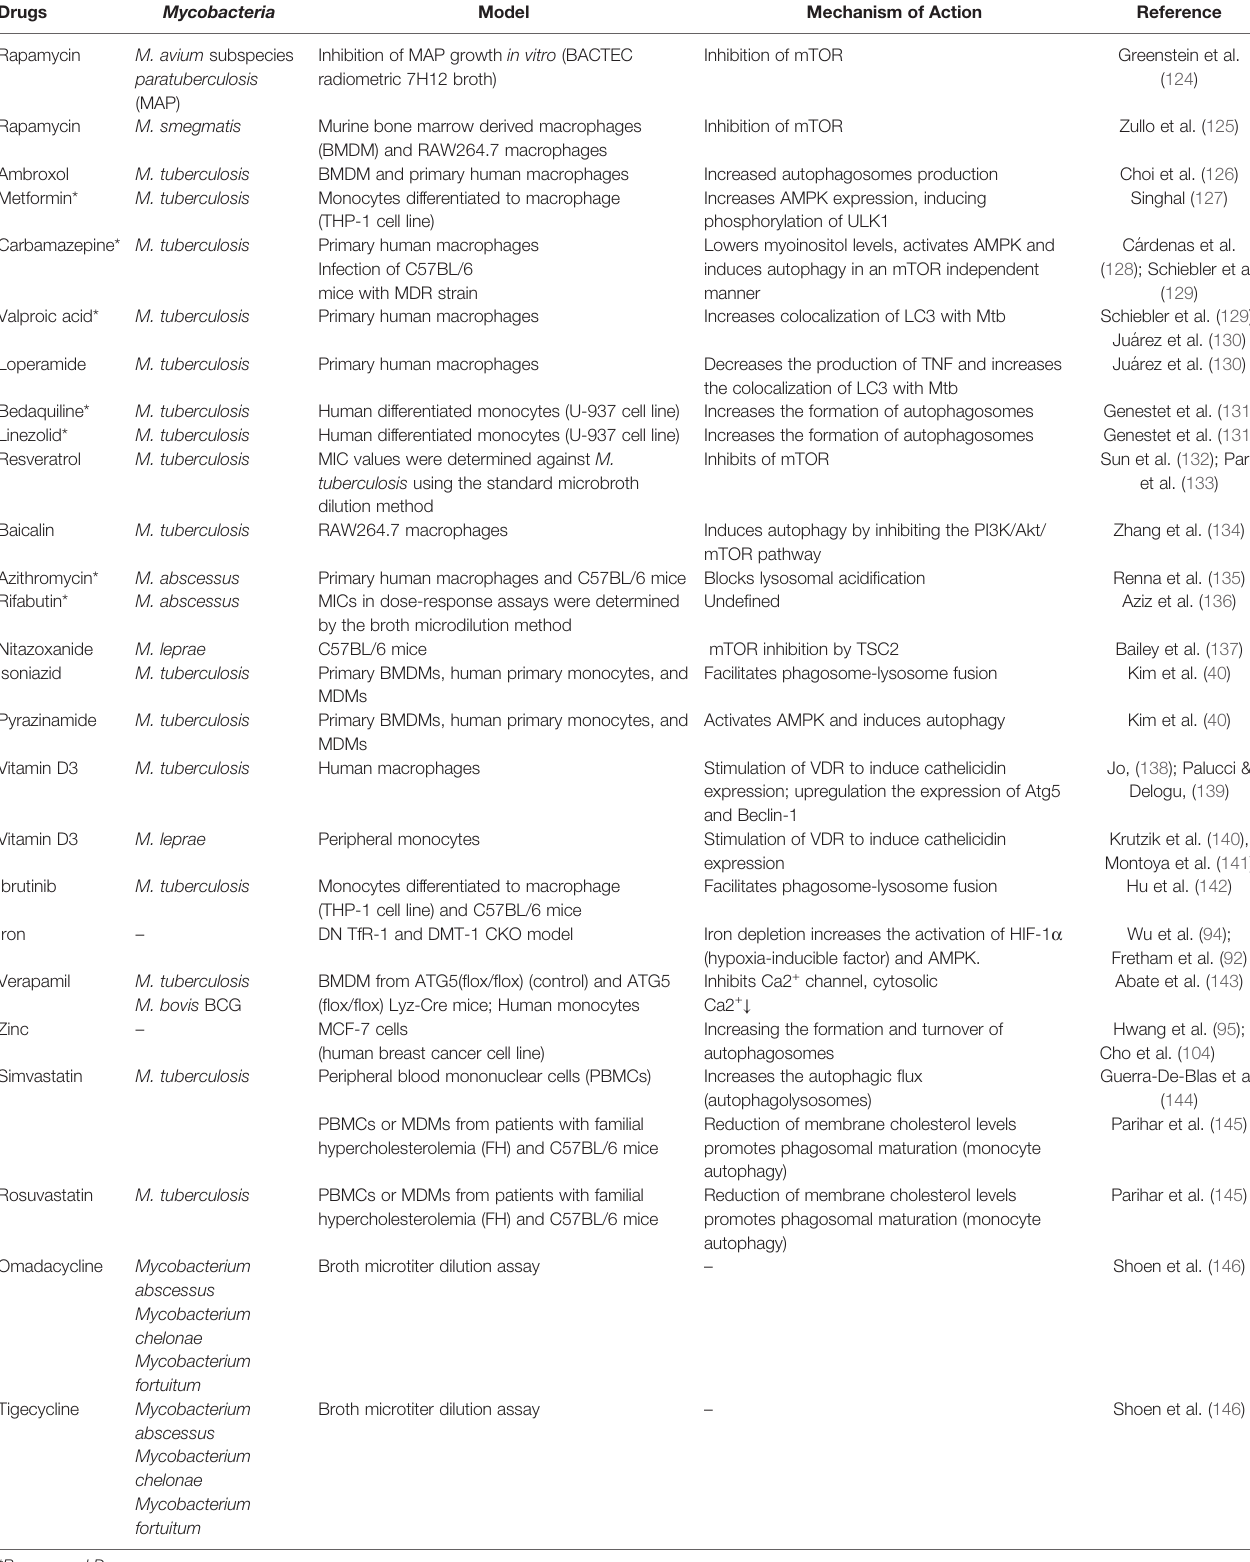
TABLE 1 | Therapeutic strategies of drug repositioning targeting autophagy of host cells against mycobacterial